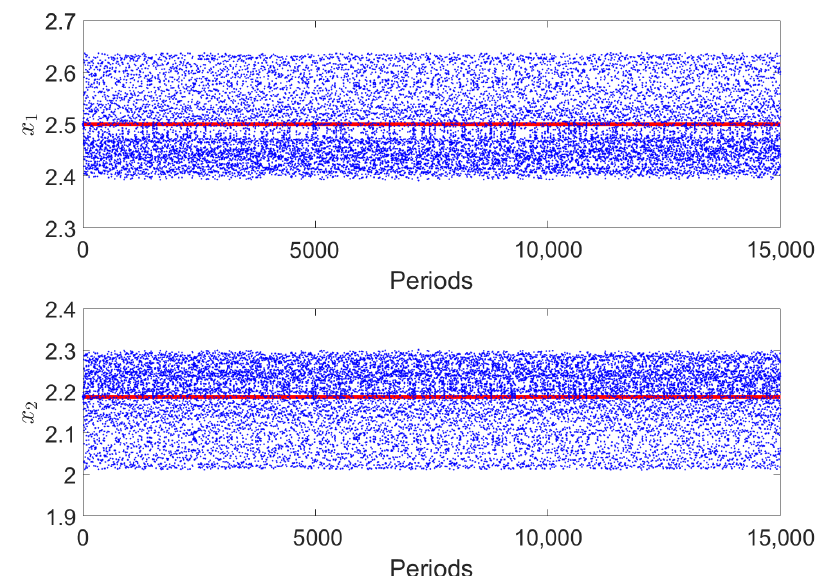
Figure 11. Behavior of the regulation. The scattered points in Figure 12 correspond to the evolution of the duty cycle, and they confirm that the system is operating in a chaotic regime.